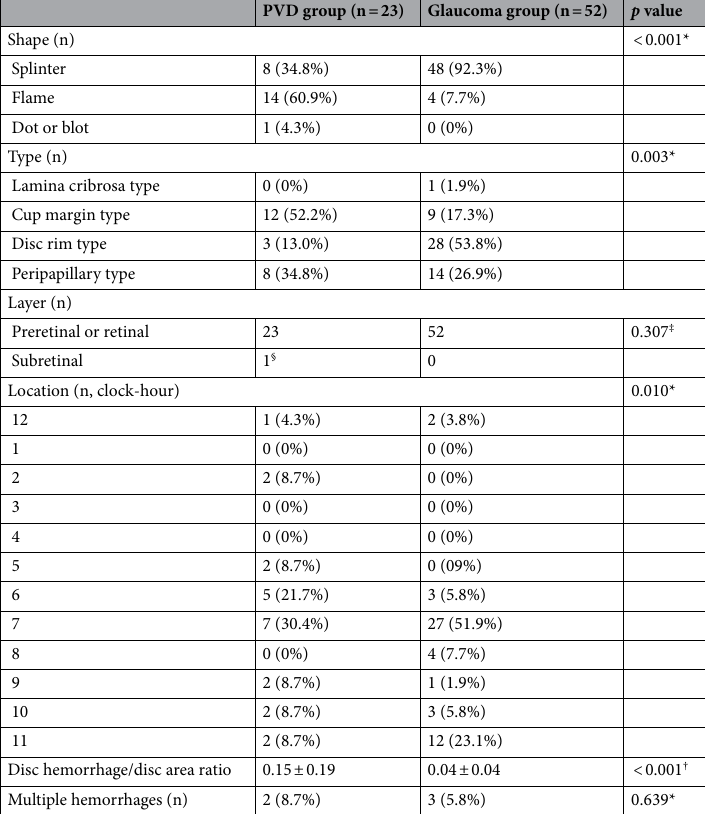
Table 2. Features of optic disc hemorrhage in eyes with posterior vitreous detachment-related optic disc hemorrhage (PVD group) and glaucomatous optic disc hemorrhage (glaucoma group). PVD posterior vitreous detachment. *Chi-square test. † Independent t-test. ‡ Fisher’s exact test. § Disc hemorrhage was found both in retinal and subretinal layers within an